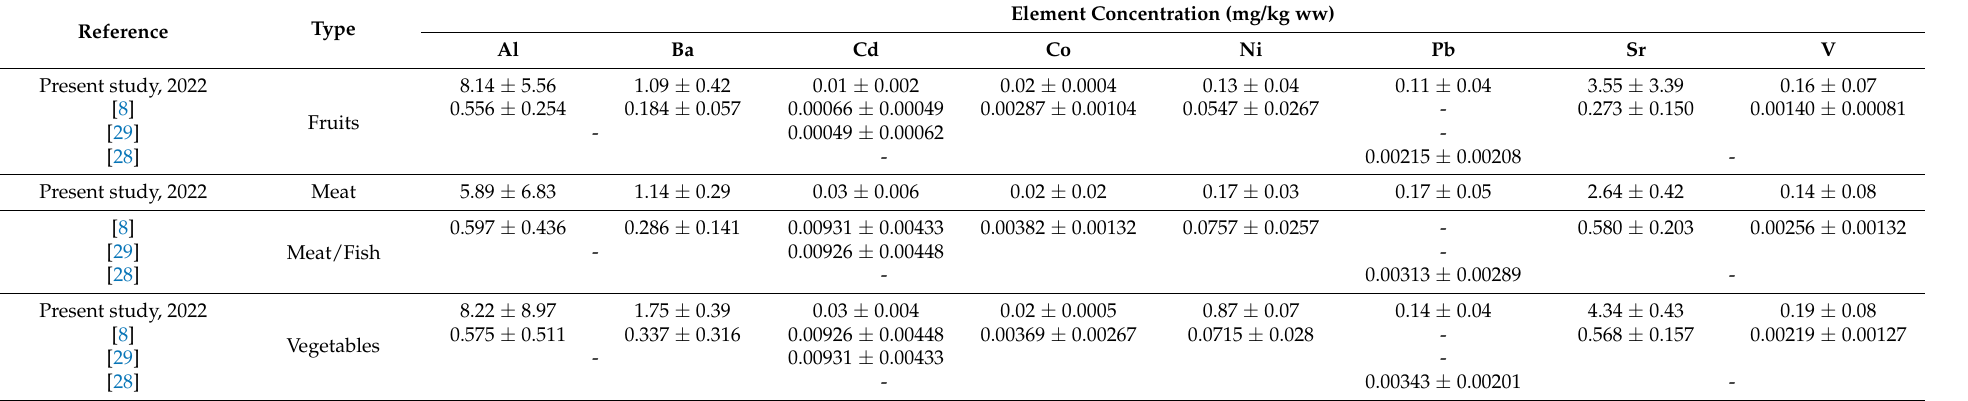
Table 6. Comparison of the obtained results with other authors.